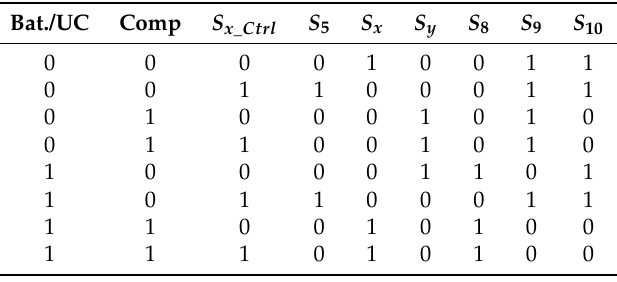
Figure 13. Block diagram of the control strategy of the charge from the grid. Table 6. Behavior of the charge decoder.